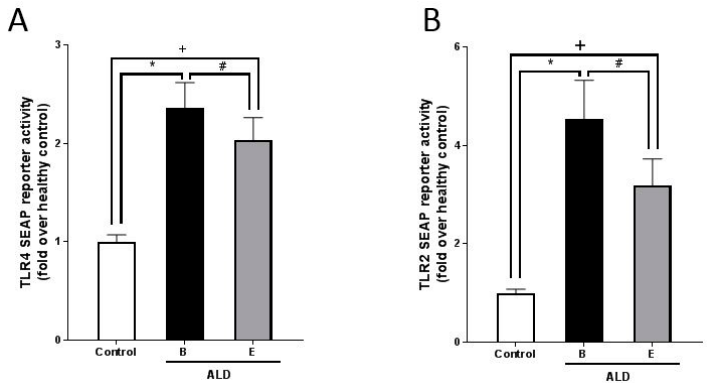
Figure 2. Concentration of TLR2 and TLR4 ligands in serum as determined by assessing activation of TLR4 and TLR2 transfected HEK293 cells, respectively, incubated with serum of controls and patients with ALD before and after alcohol withdrawal. SEAP reporter activity in HEK 293 cells transfected with ( A ) human TLR4 receptor and ( B ) human TLR2 receptor, respectively, challenged with serum of controls and patients with ALD. ALD: alcohol-related liver disease, B: beginning of alcohol withdrawal, E: end of alcohol withdrawal, SEAP: secreted embryonic alkaline phosphatase, TLR = toll-like receptor: Data are shown as mean ± SEM. Levels of significance for: # p = 0.05, * p = 0.05, + p = 0.05.